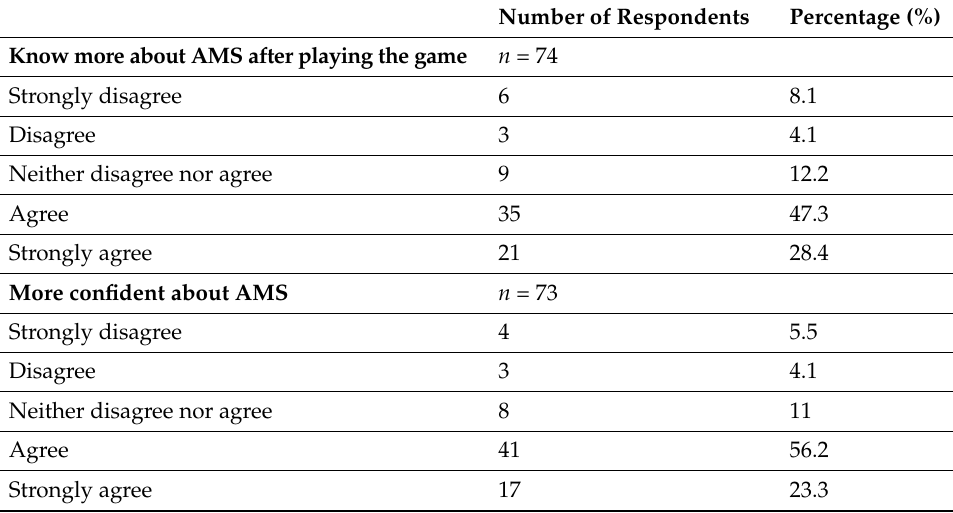
Table 4. Knowledge and confidence gain after playing the game.